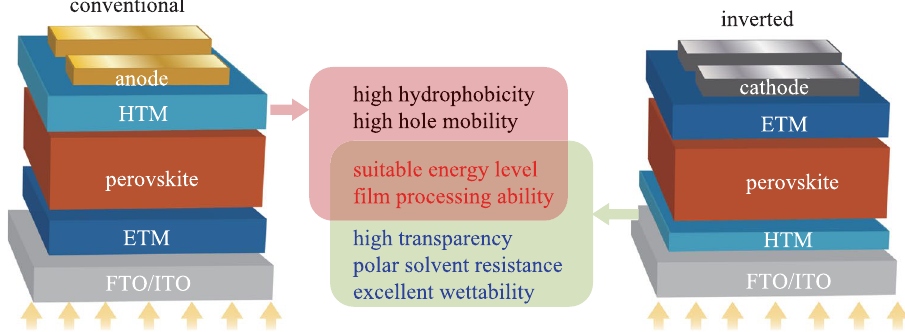
Fig. 1 Materials requirements for developing high-performance HTMs in conventional and inverted PVSCs. ITO indium-tin oxide, FTO fluorine doped tin